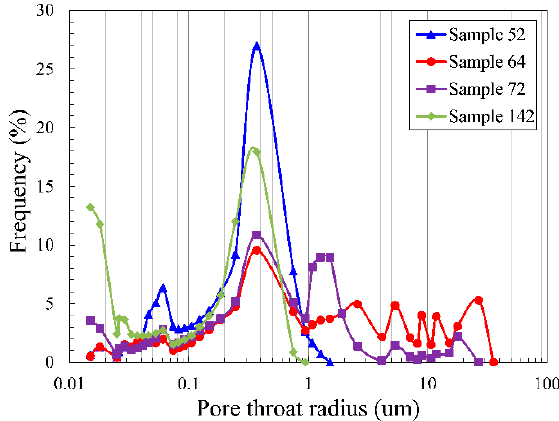
Figure 2. Pore size distributions of four samples obtained using mercury analysis.